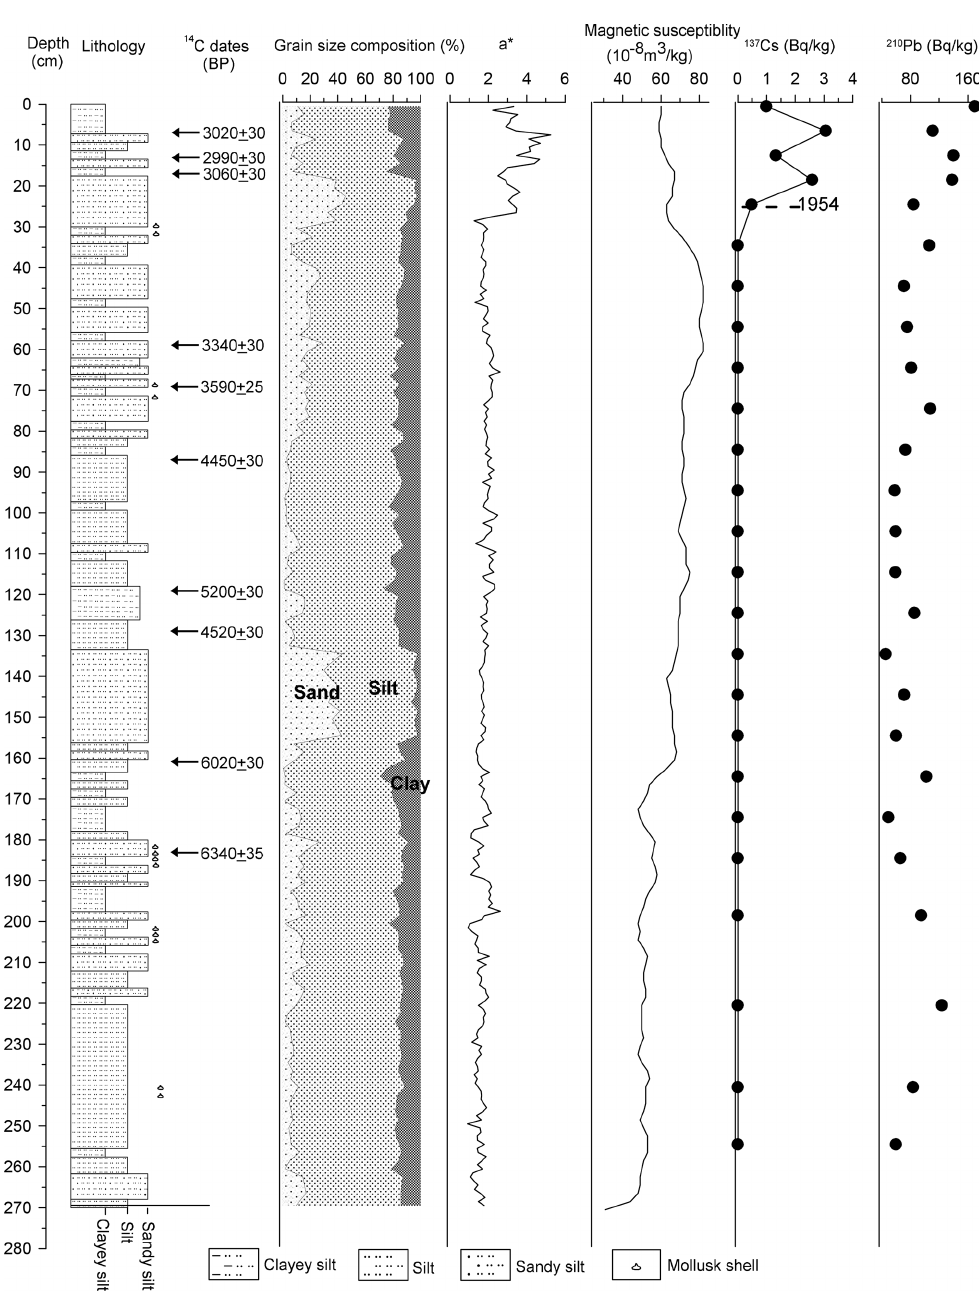
(Fig. 4). Percentages of conifer pollen were relatively low compared with other zones: Pinus ranges from 19.7 % to 45.6 % (mean 33.6 %), and Taxodiaceae was present only of non-arboreal pollen types, Compositae (mean 1.2 %), Artemisia (mean 4.2 %) and Chenopodiaceae (mean 5.6